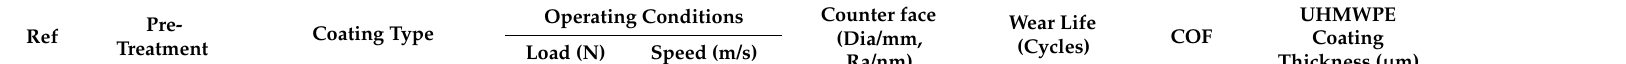
Table 7. Summary of the literature of UHMWPE coatings for MEMS